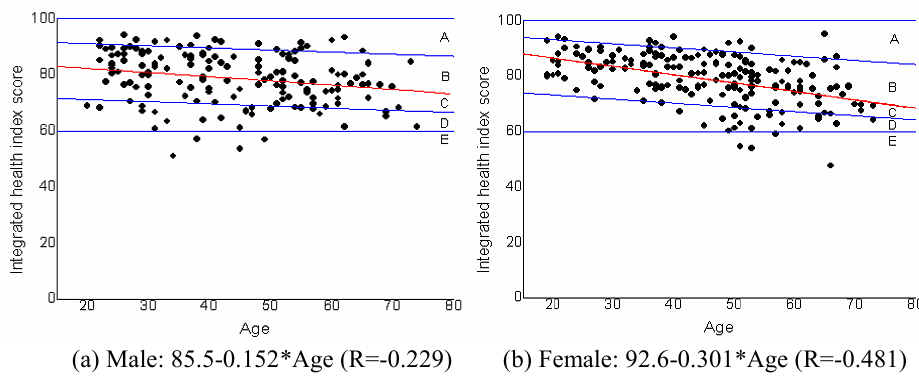
(a) Male: 85.5-0.152*Age (R=-0.229) Fig. 7 Regression equation and classification of five regions for integrated health